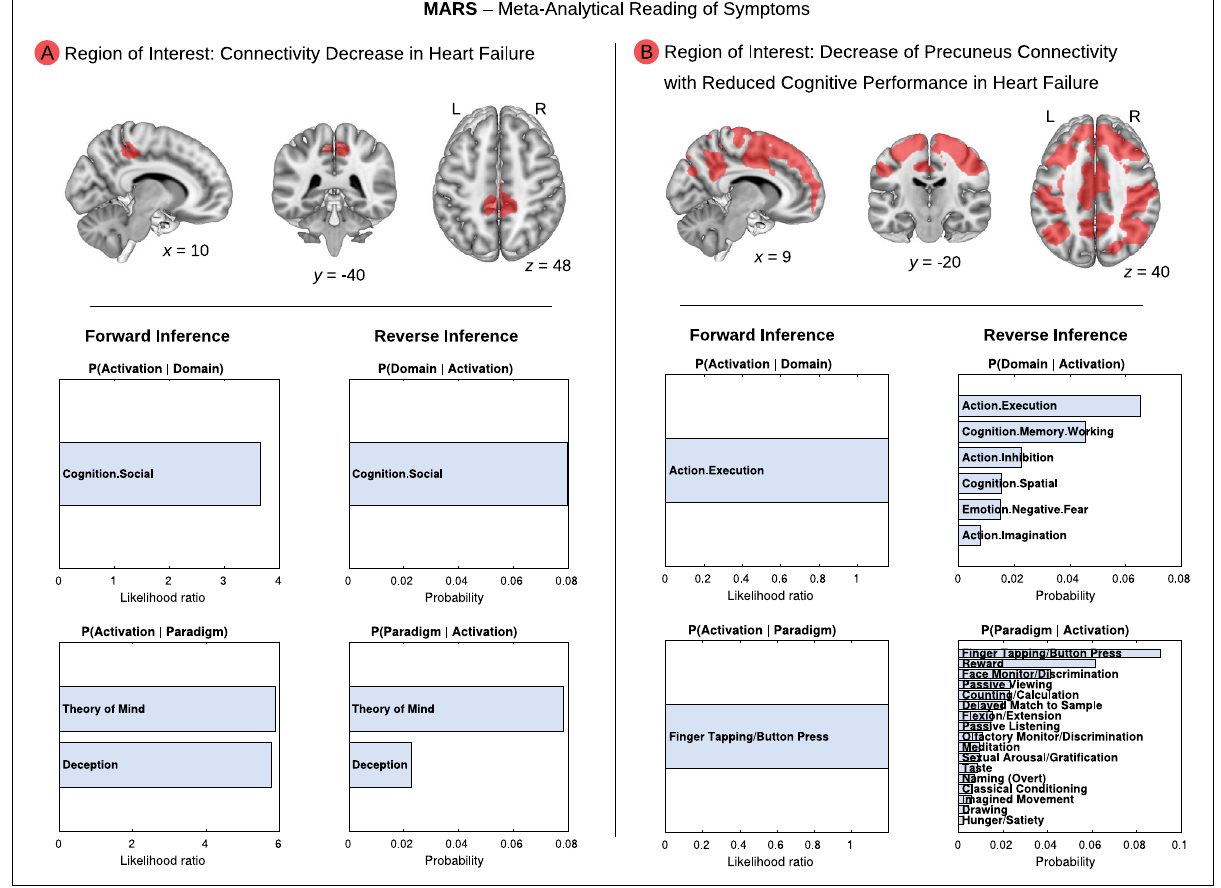
Figure 3. Meta-analytical data-mining shows that neural networks affected by heart failure (HF) are mainly related to executive and social abilities—BrainMap database. Top panel illustrates in red color ( A ) connectivity decrease in HF in the precuneus (left) and ( B ) the neural network originating from a seed-based correlation analysis showing decreased precuneus connectivity with reduced cognitive performance in HF (right; data are identical to Fig. 1A, C). These brain areas were used as regions of interest to extract related cognitive domains with meta-analytical reading of symptoms (MARS). Lower blue panels show results for forward (likelihood ratio) and reverse inference (probability), i.e., relevant associated cognitive domains and paradigms based on a very large independent cohort from the BrainMap database. x, y, z—coordinates of the Montreal Neurological Institute (MNI) stereotactic space. L—left,